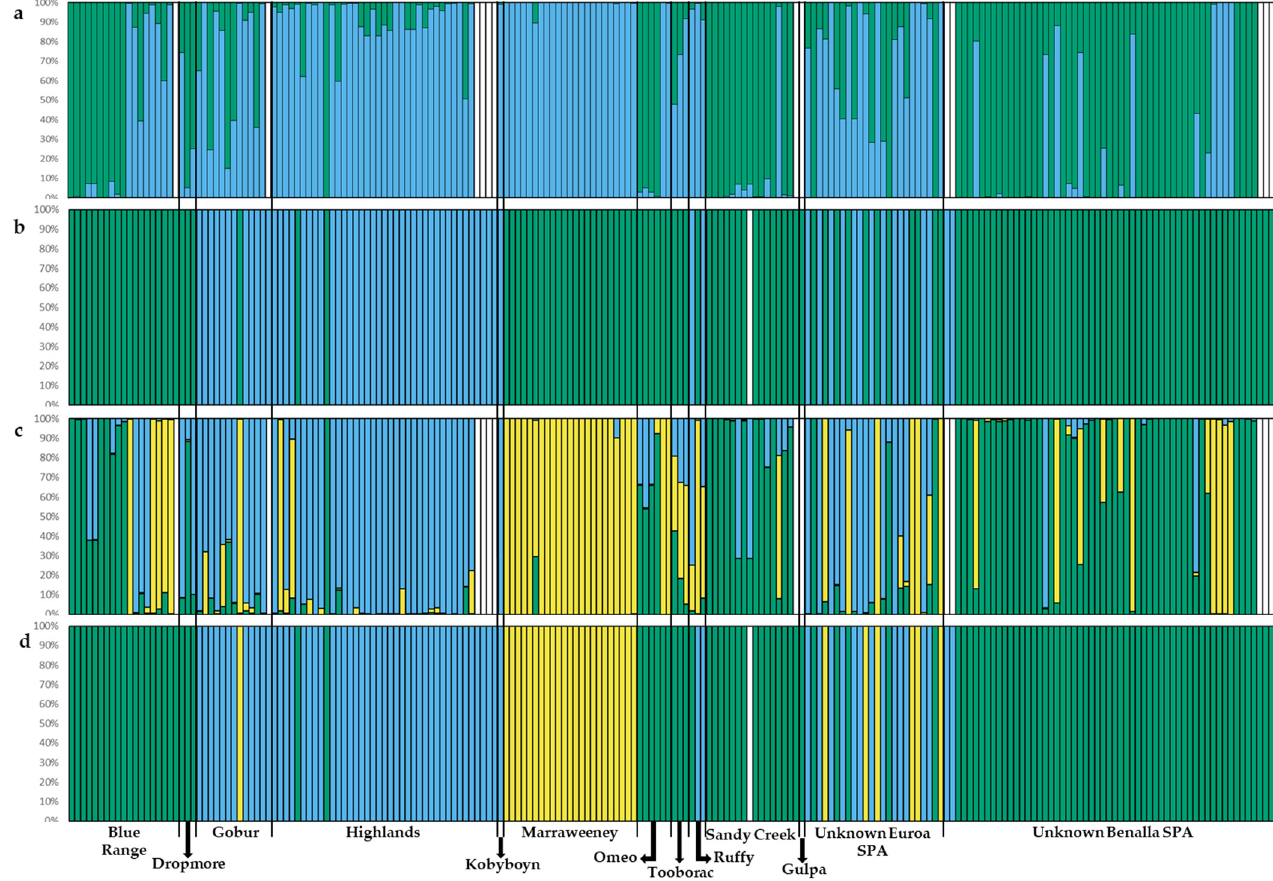
Figure 5. STRUCTURE analyses for Banksia marginata remnant and SPA trees; each bar represents a single tree. K = 2 for ( a ) SSRs and ( b ) SNP. K = 3 for ( c ) SSRs and ( d ) SNPs. Green is Cluster 1, blue is Cluster 2, yellow is Cluster 3 and white bars indicate failed reactions.